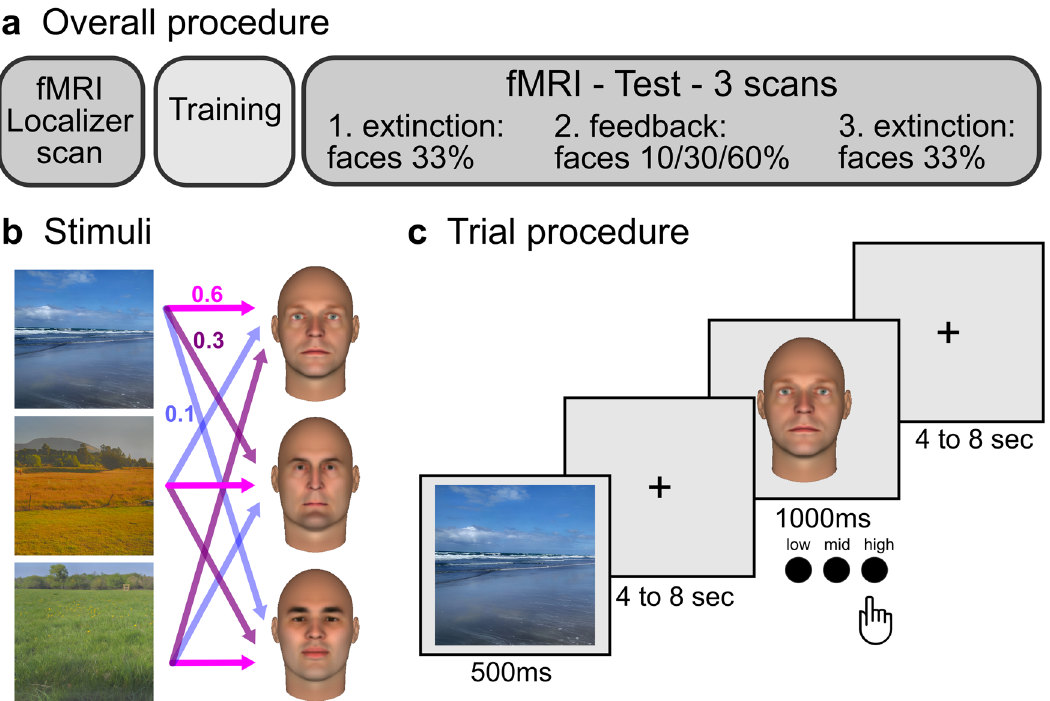
Fig. 1 Procedure and stimuli. a The experiment started with a functional localizer in the scanner (30 min) in which participants saw images of three scenes and three faces (shown in b ). This was followed by a training session outside the scanner (40 min). Finally, the main scanning session consisted of three test runs of which the fi rst and the third were extinction runs, i.e., faces were presented with equal contingencies and no feedback about correct responses was provided. The middle run was a refresher training with feedback and faces were presented with learned contingencies (i.e., 0.1, 0.3, and 0.6, 60 min). c Trial procedure during the test. Scene cues were followed by face images showing three different identities. Participants had to indicate by button press how much they had expected the presented face, given the preceding scene cue (with low, mid, or high probability).